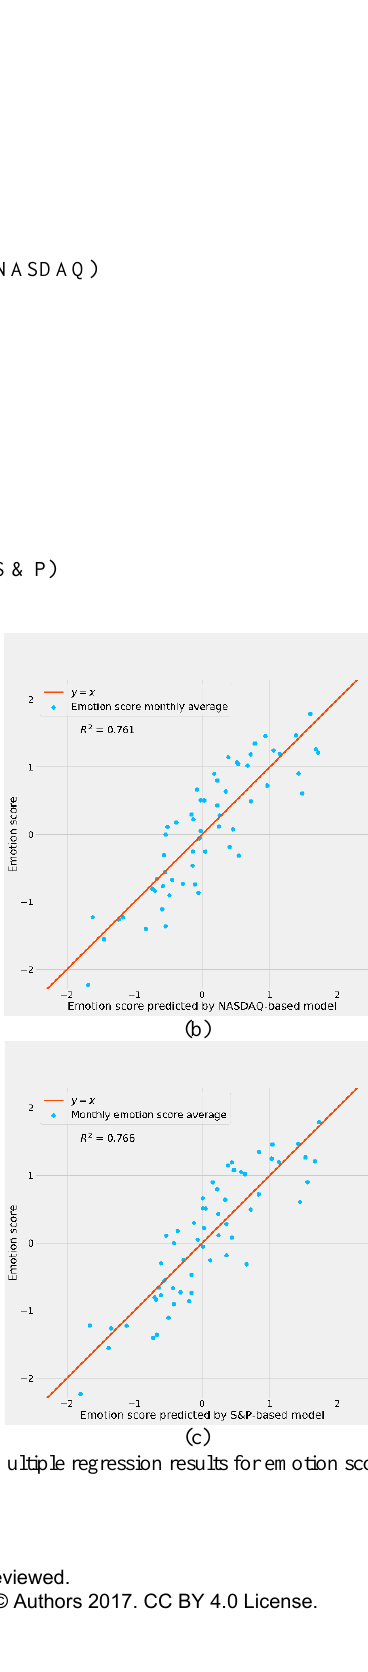
Table 3(a) Standardized regression coefficients of multiple regression models (DJIA)